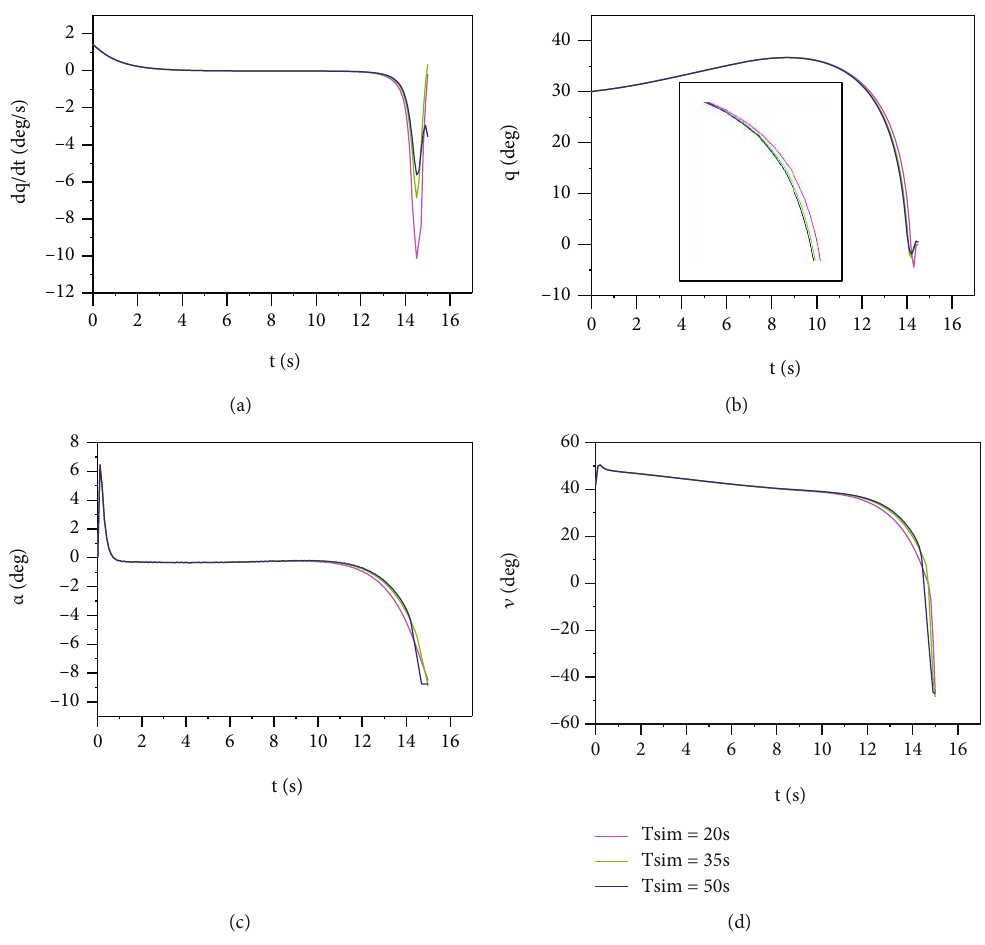
Figure 6: Simulation results under Case 2: (a) the LOS angular rate, (b) the LOS angle, (c) the attack angle, and (d) the pitch